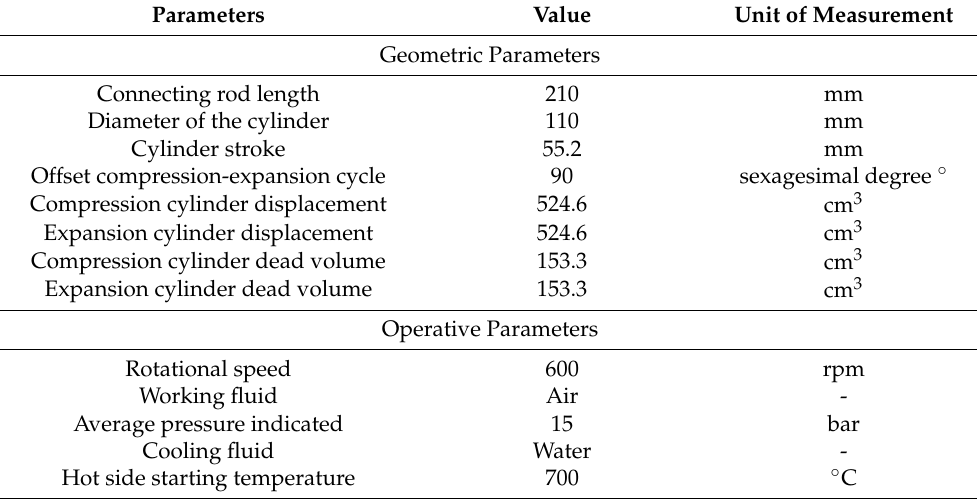
Table 2. Parameters of the